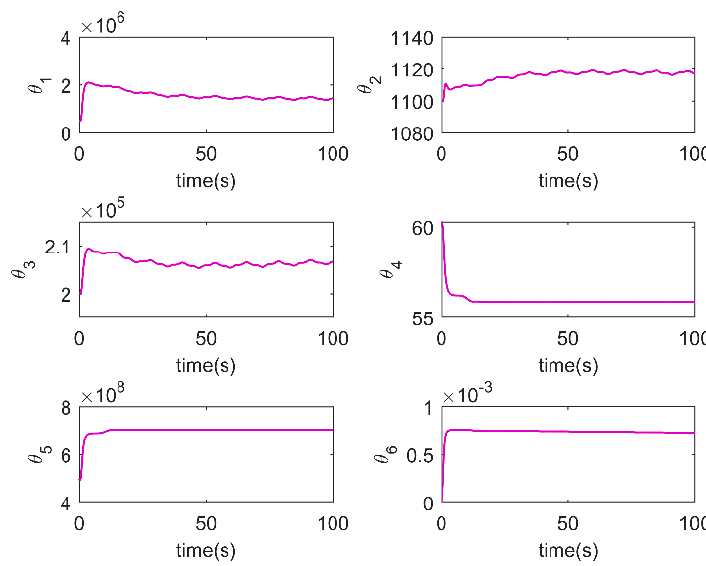
Figure 6. The parameter adaptation of ARCBF as ε = 1 × 10 − 6 .